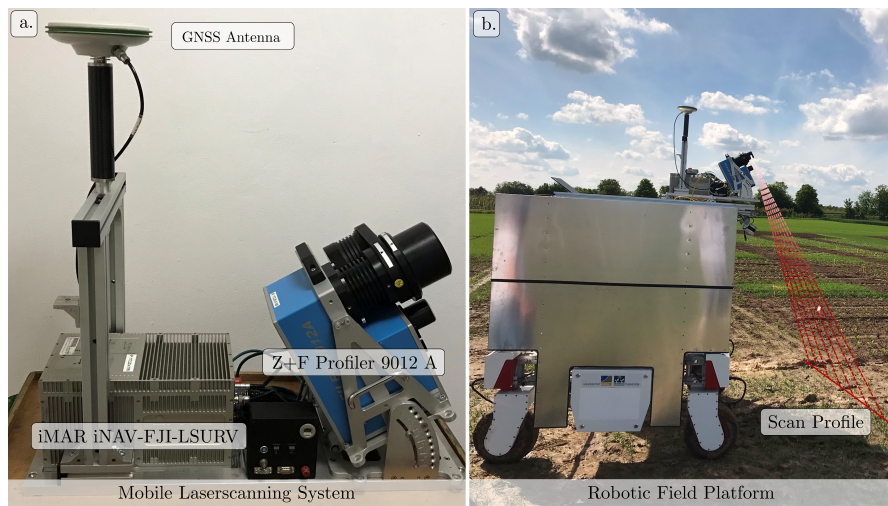
Figure 1. ( a ) Mobile laser scanning system with Leica AS10 GNSS antenna on the top, iMAR iNAV FJi-LSURV INS and profile laser scanner Z+F Profiler 9012 A; ( b ) unmanned ground robot used as carrier platform in the field, mobile laser scanning system on the roof. An angular section of the scan profile is visualized in red.